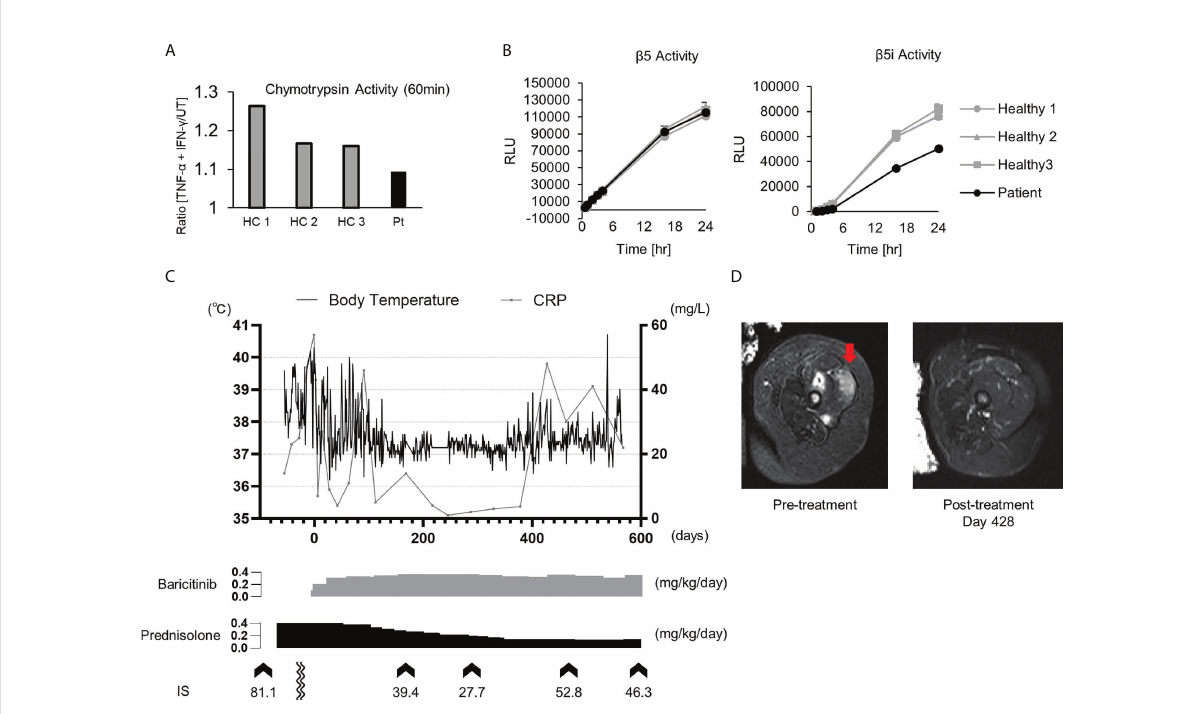
FIGURE 3 Imaging fi ndings, proteasome activity and clinical course after baricitinib application in P1. (A) Ratio of the chymotrypsin-like activity in monocytes with and without stimulation by TNF- a and IFN- g . The upregulation of chymotrypsin-like activity in monocytes from the patient (Pt) was weaker when compared to healthy controls (HCs) upon induction of the immunoproteasome assembly by IFN- g and TNF- a . (B) Depicts the chymotrypsin-like proteolytic activity of the constitutive proteasome ( b 5 subunit) and the immunoproteasome ( b 5i subunit). (C) Transitive graph showing the daily maximum body temperature, C reactive protein levels, and the intermittently measured interferon scores of the patient. (D) A T2-weighted axial MRI depicting high intensity in the femoral muscle before (left) and after (right) treatment with